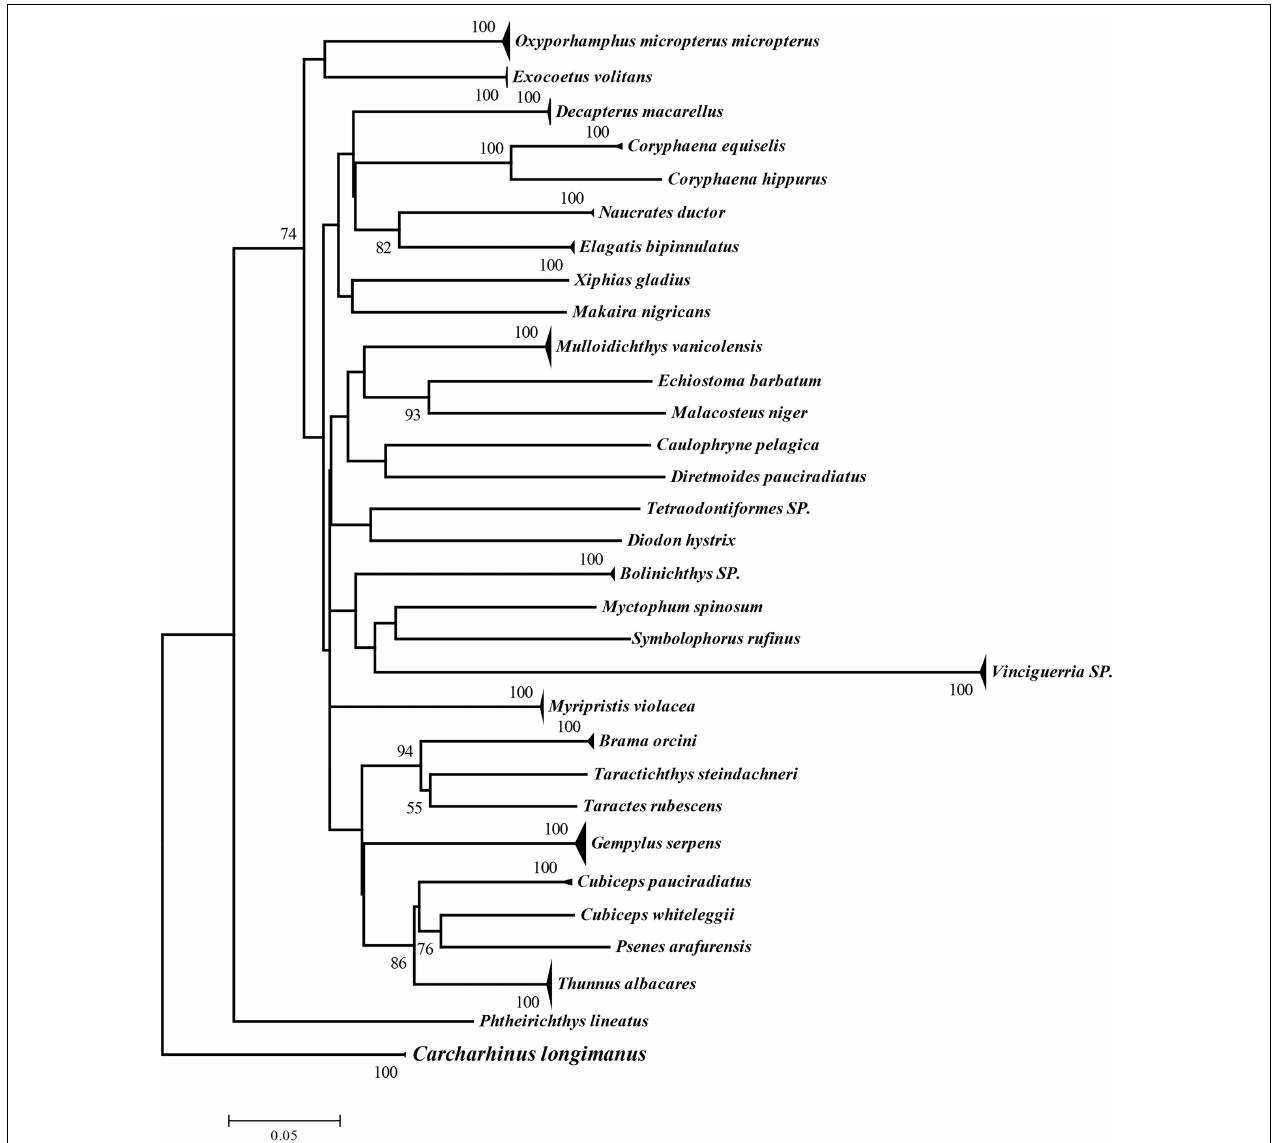
FIGURE 2 | Neighbor-joining phylogenetic tree for surface-dwelling ichthyoplankton from above Ninety East Ridge based on the K2P model.